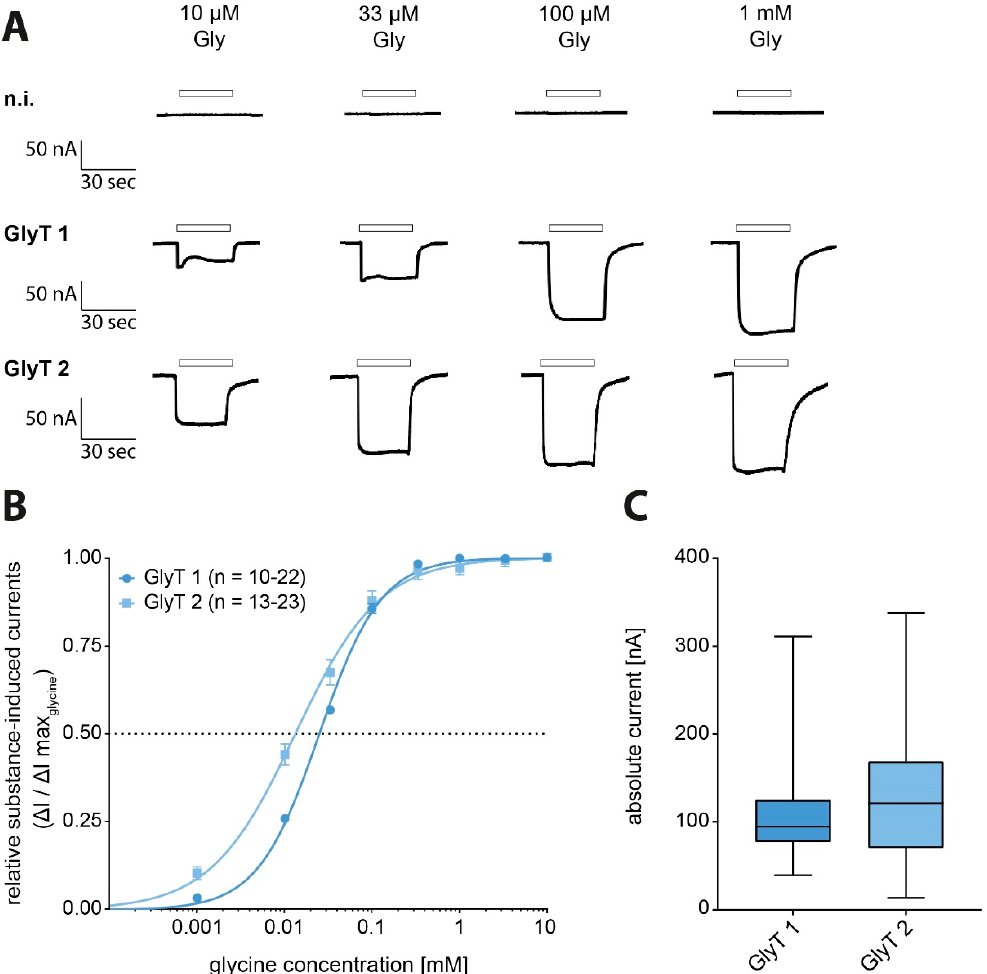
Figure 2. Functional analysis of glycine transporters (GlyTs) with glycine-induced dose-dependent current responses. ( A ) Representative current traces of original electrophysiological recordings from Xenopus laevis oocytes expressing GlyT1 or GlyT2, compared to non-injected oocytes after superfusion with glycine solution in increasing concentrations. Substance application is indicated by open box above the trace. ( B ) Dose–response curves of GlyTs showing the glycine-induced currents in relation to the maximum observed current induced by 10 mM glycine (GlyT1 n = 10–22, GlyT2 n = 13–23). ( C ) Maximum glycine-induced current amplitudes (nA) determined on oocytes expressing transporter individually taken together from all measurements (GlyT1 n = 148; GlyT2 n = 130; data presented as